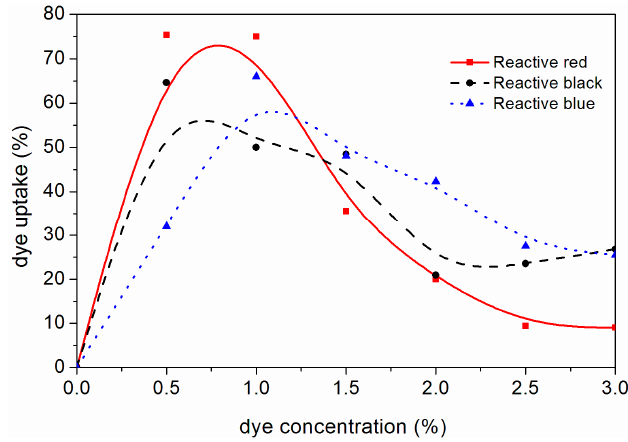
Figure 2. Effects of reactive brilliant red X-3B, black KN-B and blue K-3R dye concentrations on dye uptake.